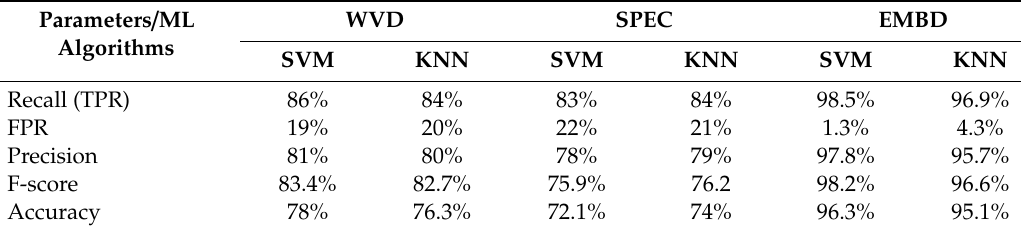
Table 5. Evaluation parameters in classifying T-wave